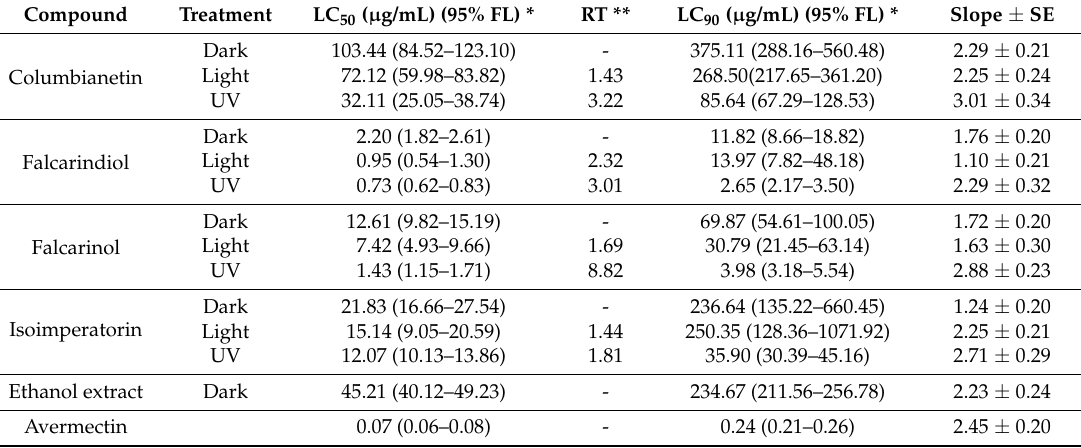
Table 1. Nematicidal activity of bioactive compounds from Notopterygium incisum rhizomes against Bursaphelenchus xylophilus